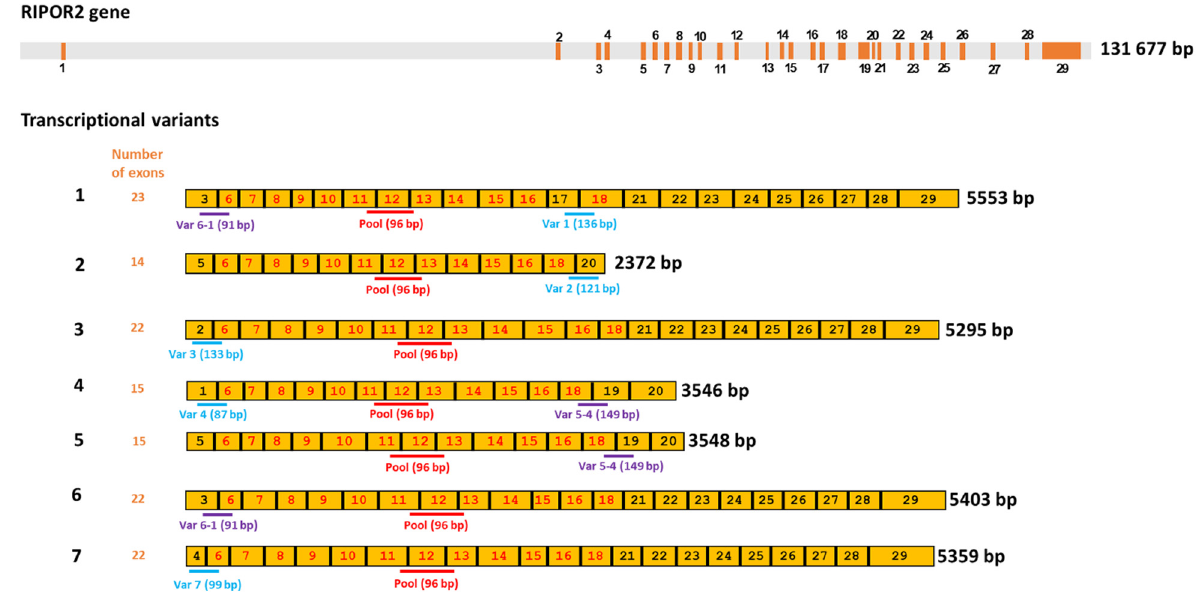
Figure 8. Human RIPOR2 gene and its transcriptional variants. Upper grey bar shows the position of introns in RIPOR2 gene, whereas the enumerated orange boxes, the exons of the gene. Seven transcriptional variants are enlisted under the gene in yellow color, showing the enumeration of the exons that comprise each transcript (1–7). Exons with numbers in red color are those shared by all the transcripts. Below the representation of each the transcriptional variant, the position of the specific primers and the size of the expected amplicon is shown. The pool primers amplify a fragment (shown in red) within a common region. Exons with the numbers in black color are only shared by some transcripts; therefore, primers for specific variants were designed within these areas. Amplicons shown in blue are those that allow the detection of a given specific variant, whereas amplicons in purple are shared by two variants (i.e., variants 1 and 6; variants 4 and 5).